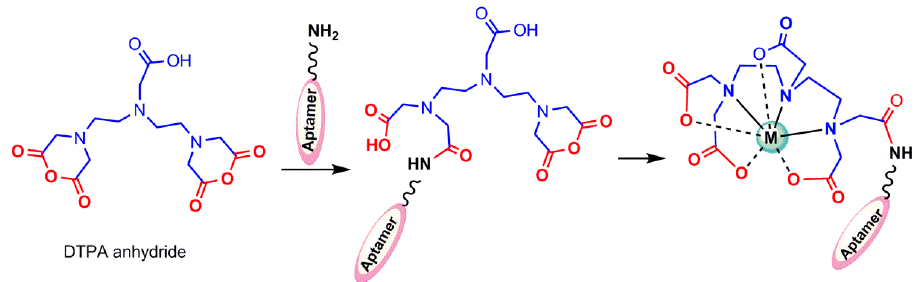
Figure 5. Conjugation of the diethylenetriaminepentaacetic acid (DTPA) anhydride to an amine ‐ derivatized aptamer, and